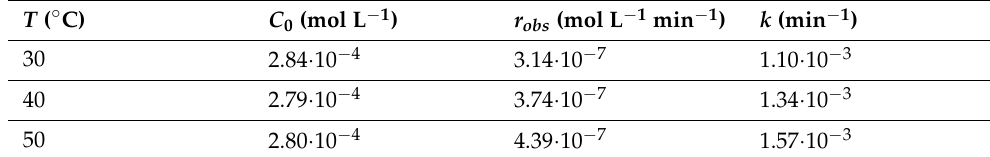
By plo tt ing ln ( k ) vs. 1/ T, the Arrhenius plot for the process was elaborated, as depicted in Figure 9.